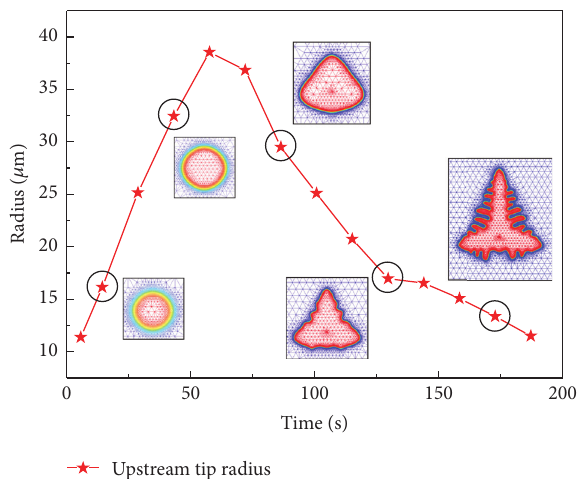
Figure 7: The corresponding crystal shape to the variation of the tip radius of the upstream arm.